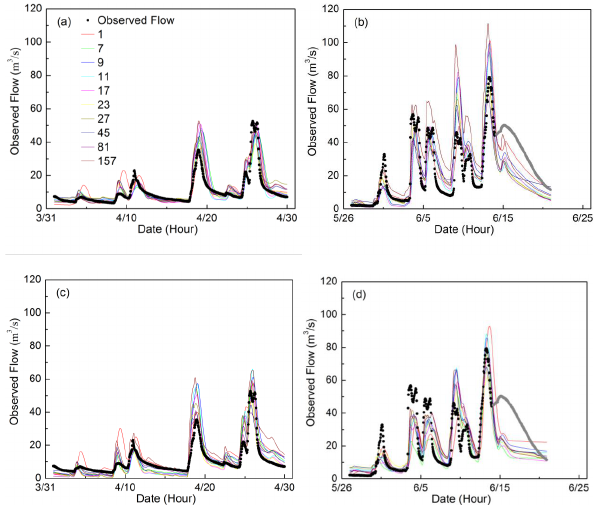
Fig. 5. Calculated hydrographs at Coralville with scenarios of Fig. 5 Calculated hydrographs at Coralville with scenarios of: (a) April; (b) June; (c) April 4 (a) April, (b) June, (c) April flood with parameters of June (PJ), flood with Parameters of June (PJ); (d) June flood with Parameters of Aprill (PA) 5 and (d) June flood with parameters of Aprill (PA). 6